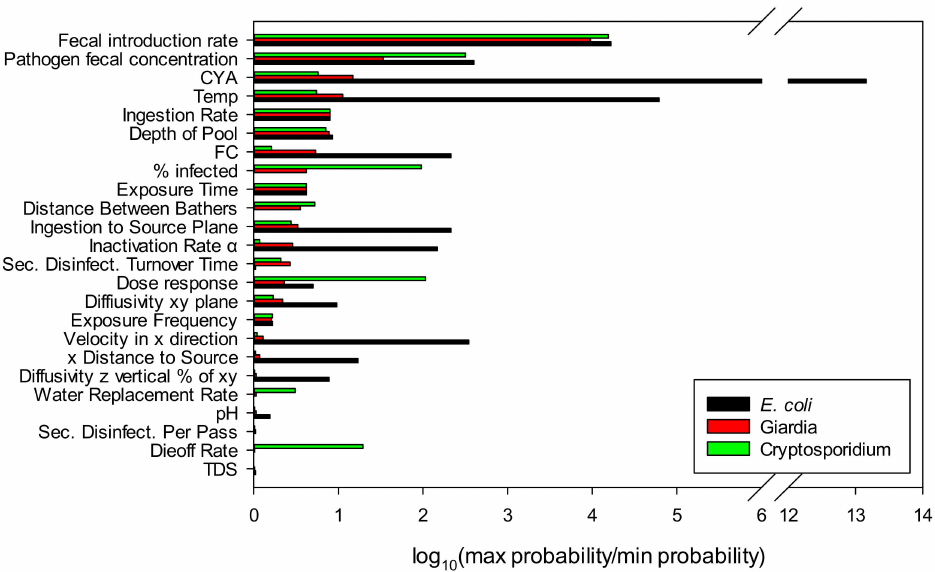
Figure 5. Sensitivity analysis: The sensitivity is shown by the log of the maximum probability divided by the minimum probability for each